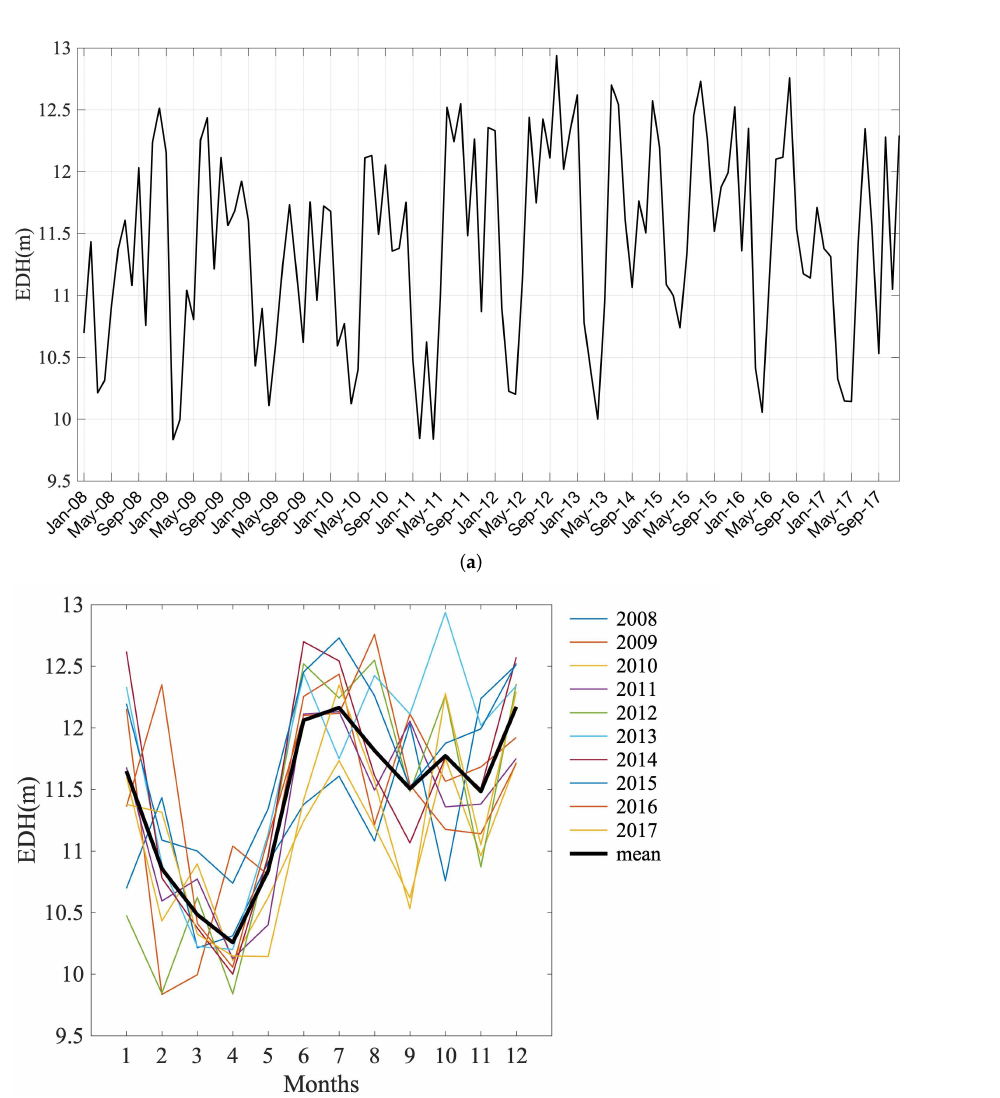
Figure 2. Monthly Variation of EDH during 2008–2017 over South China Sea ( a ) monthly trend ( b ) long-term monthly